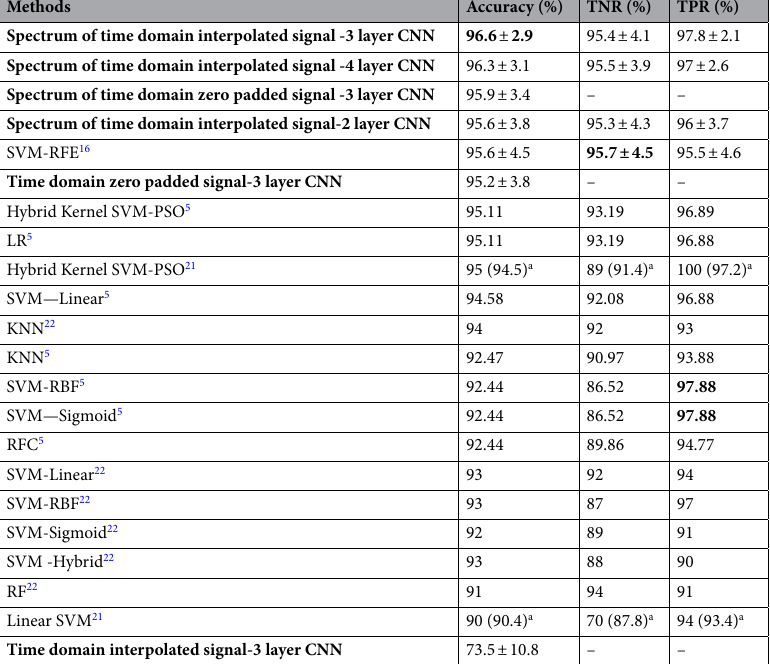
Table 1. Results for the tested signal pre-processing, representations, and CNN structures in comparison to other published methods. The suggested methods are in bold and all methods are sorted by their accuracies. a We believe this is a correct value calculated as an average over tenfold results that were provided by the authors, but possibly incorrectly listed in their comparison